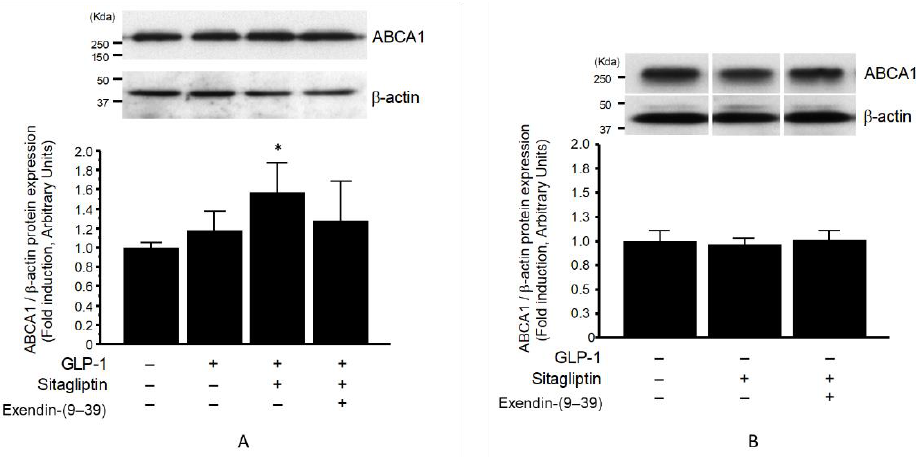
Figure 4. Effect of sitagliptin (1 µ mol/L) in the presence ( n = 5–8) ( A ) or absence ( n = 3–4) ( B ) of GLP-1 (10 nmol/L) on ABCA1 protein expression in the cell membrane fraction of THP-1 cells. Values represent mean ± SD. * p < 0.05 vs. GLP-1 ( – ).